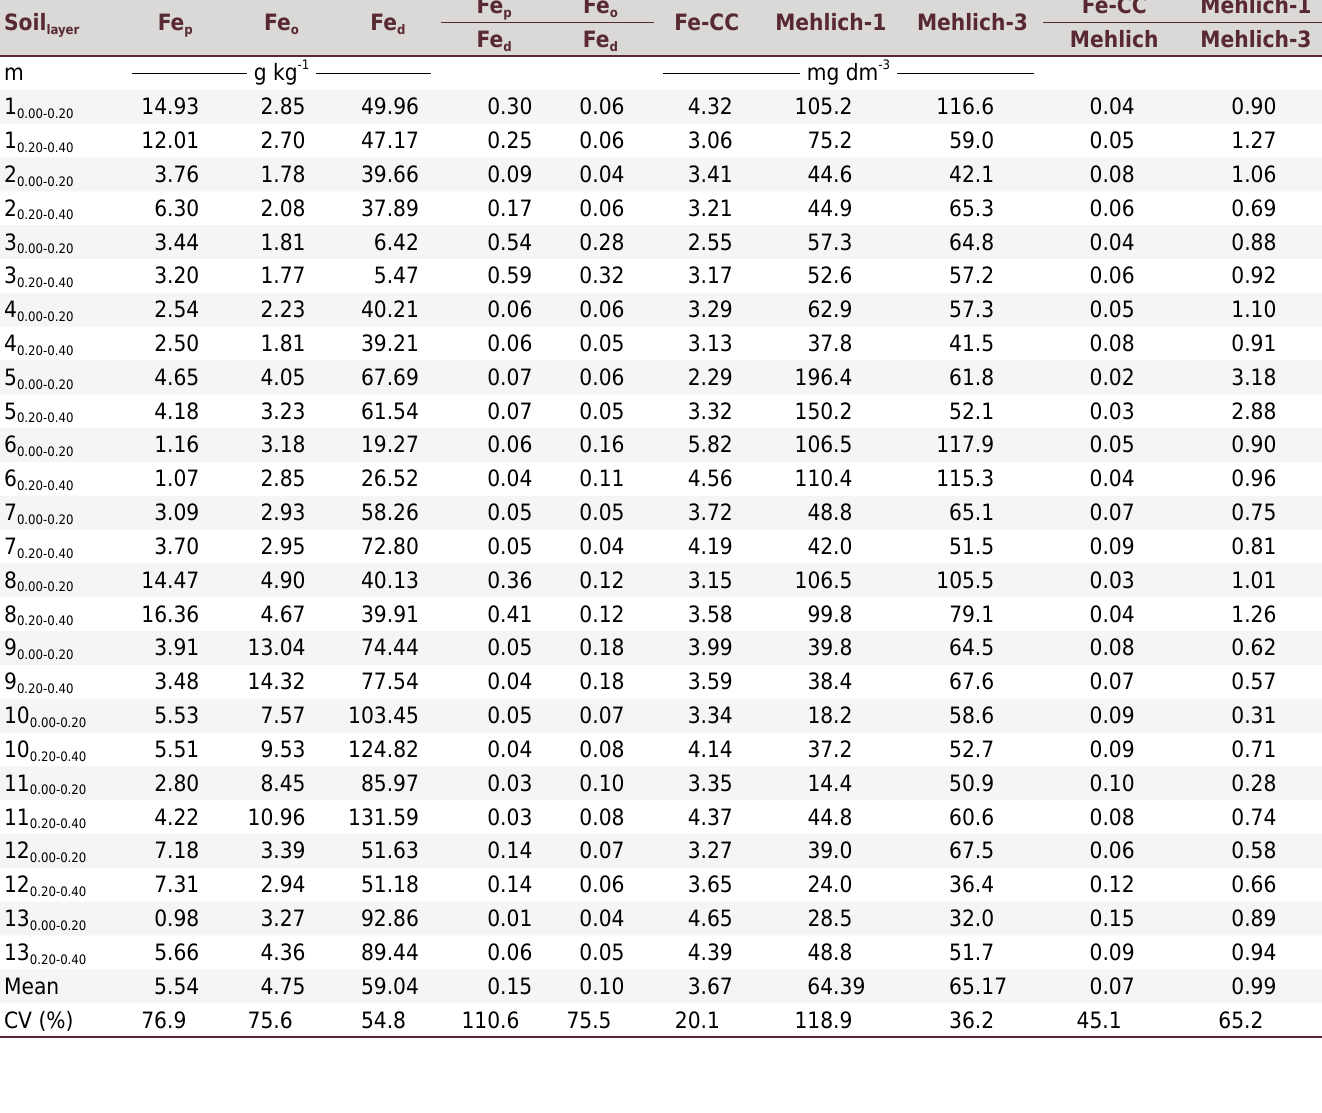
Table 3. Concentration of Fe extracted by pyrophosphate (Fe p ), ammonium oxalate (Fe o ), dithionite-citrate (Fe d ), calcium chloride (Fe-CC), Mehlich-1, and Mehlich-3 and their relationships in samples of 13 soils at two depths (0.00-0.20 and 0.20-0.40 m) Soil layer